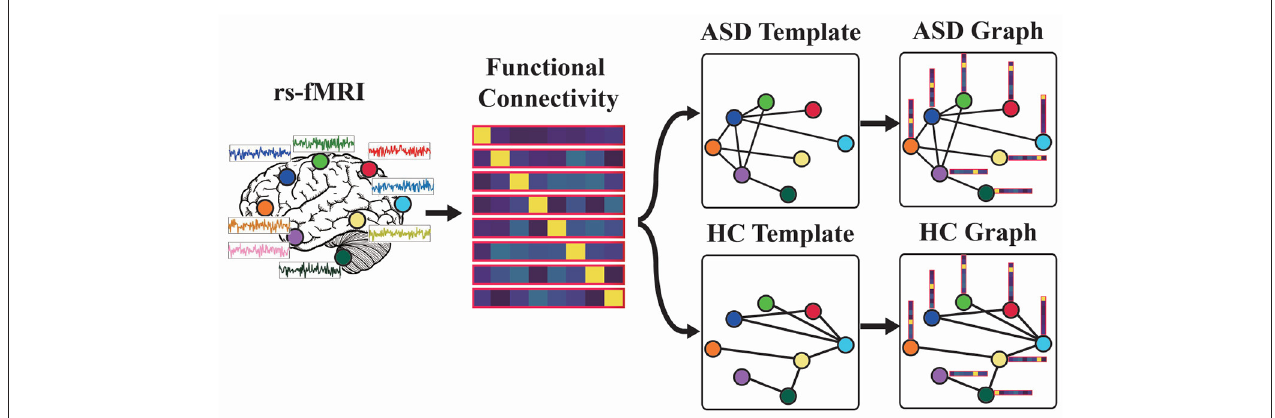
FIGURE 1 | Functional graph construction: (1) Estimate functional connectivity matrix for each resting-state functional magnetic resonance imaging (rs-fMRI). (2) Build autism spectrum disorder/healthy controls (ASD/HC) template based on the mean functional connectivity matrix of ASD/HC samples. (3) Construct ASD and HC